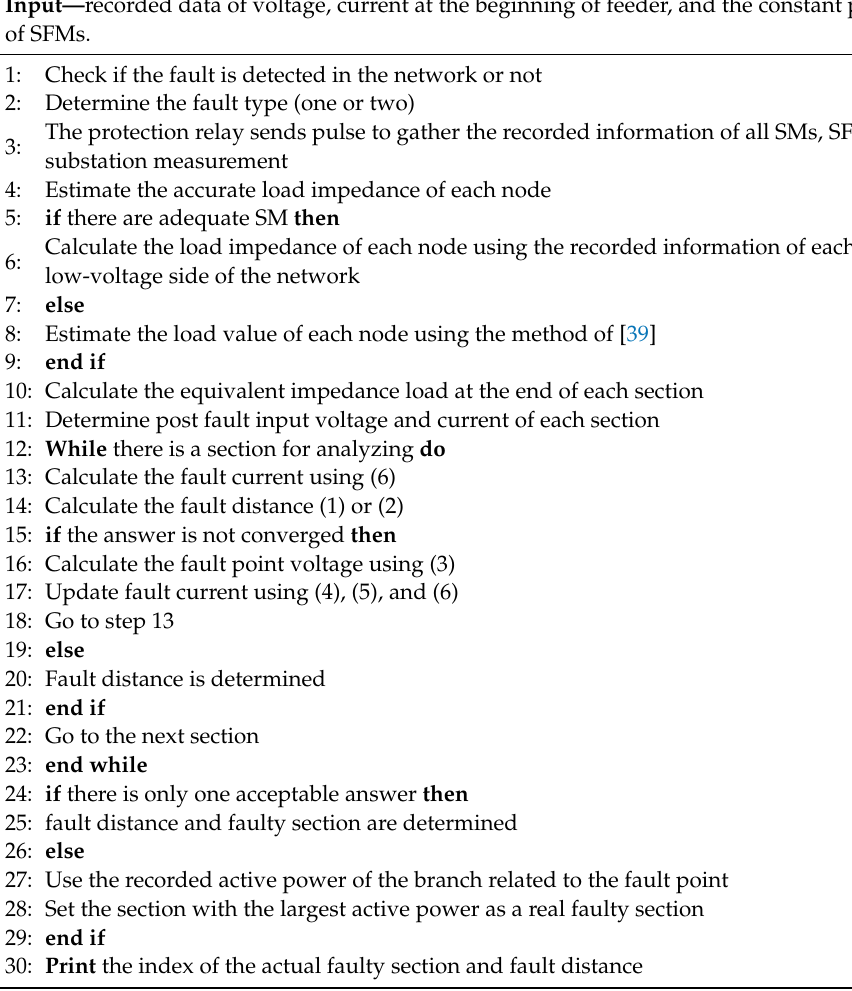
Algorithm 1. Impedance-based FL